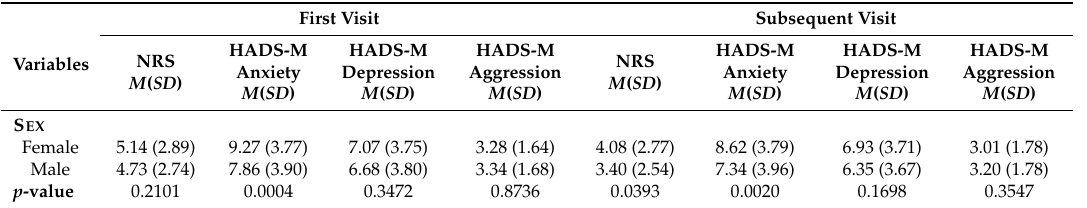
Table 3. Statistical analysis of pain intensity and emotional disturbances during the first and subsequent visit at the pain clinic depending on the sex of the patients examined.